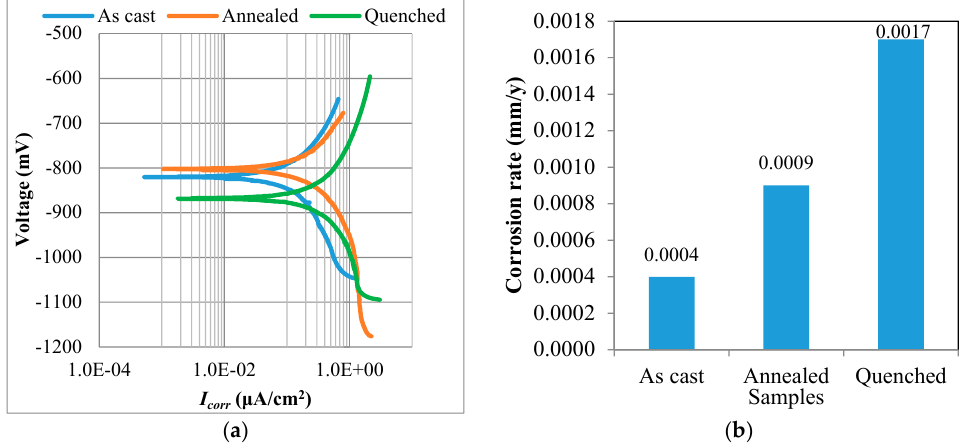
Figure 5. ( a ) Tafel curves and ( b ) corrosion rates of the as-cast and heat-treated Ti 34 V 40 Cr 24 Fe 2 .